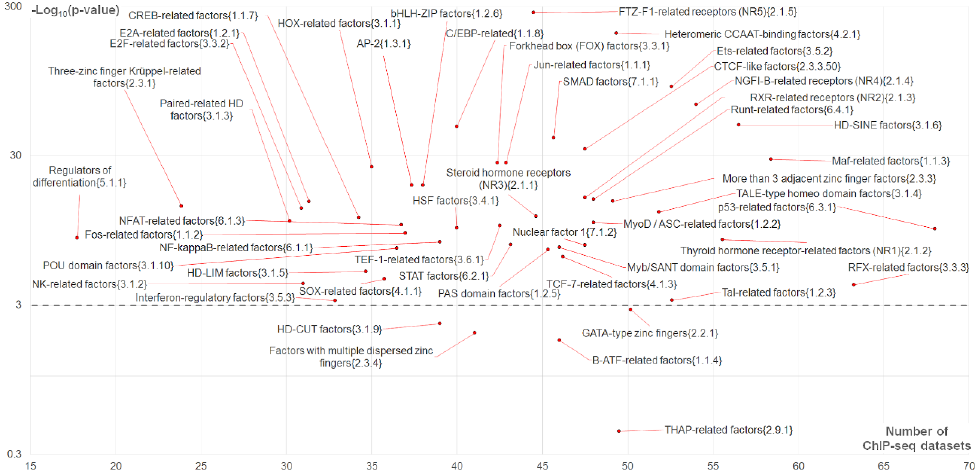
Figure 5. The significance of enrichment of asymmetric CEs toward the partner motifs as a function of CE abundance. The scatterplot shows 50 clades of partner TFs, including 49 families of TFs with at least two motifs and subfamily CTCF-like factors {2.3.3.50} with two motifs from the human core Hocomoco collection [14]. The total number of ChIP-seq datasets is 119 (Table S1). Axis X implies the number of ChIP-seq datasets with predicted CEs with an overlap of anchor motifs and partner motifs from a specific clade and without taking into account motifs conservation. Axis Y shows the significance of the Welch’s t -test that for each clade compare the number of datasets containing asymmetric CEs toward partner motifs and overlaps of motifs and the respective number of datasets containing asymmetric CEs toward anchor motifs. The horizontal dashed line marks Bonferroni’s correction for the t -test significance, -Log 10 ( p -value) = 3.